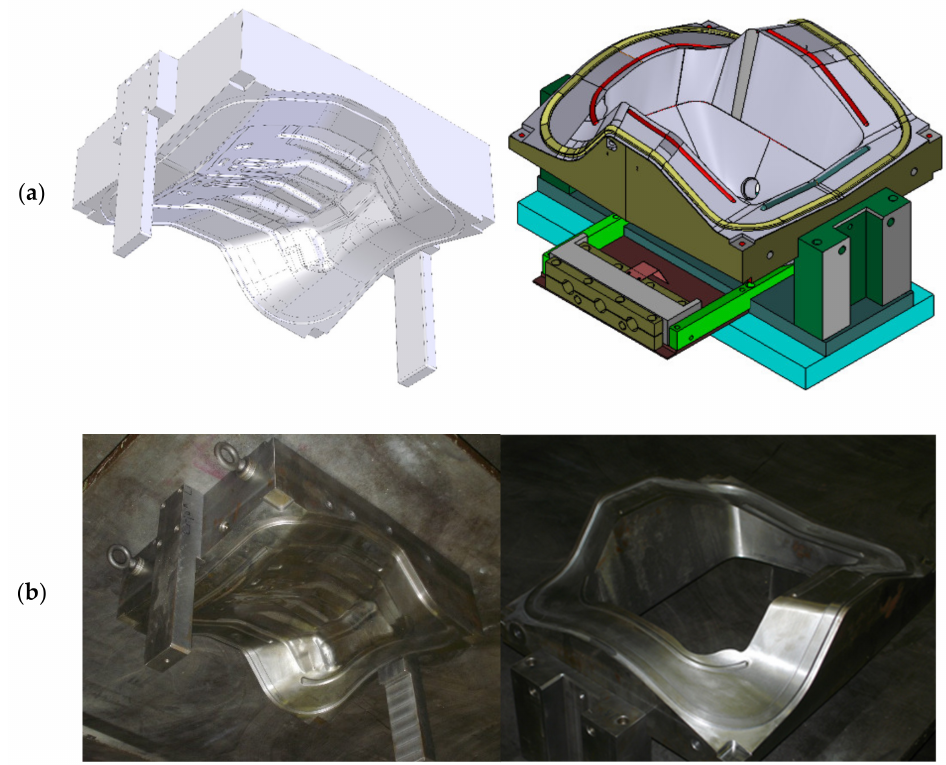
Figure 9. Die and chamber design ( a ), and fabricated die and chamber ( b ). This part has multiple channels and a deep cavity with curvatures of the flange in two directions. This part was formed as a prototype in 40% scale: every dimension was reduced by a factor of 2.5. The in-plane dimensions of the EHF formed part were 521 mm (instead of 1302) × 448 mm (instead of 1012 mm), and the maximum depth of the cavity was 126 mm (instead of 315 mm). The sheet material used for this prototype process was 0.55 mm DP500 steel. The experimental results on sheet metal behavior at high strain rates for numerical simulation were taken from the study by Baumer et al. [48], and